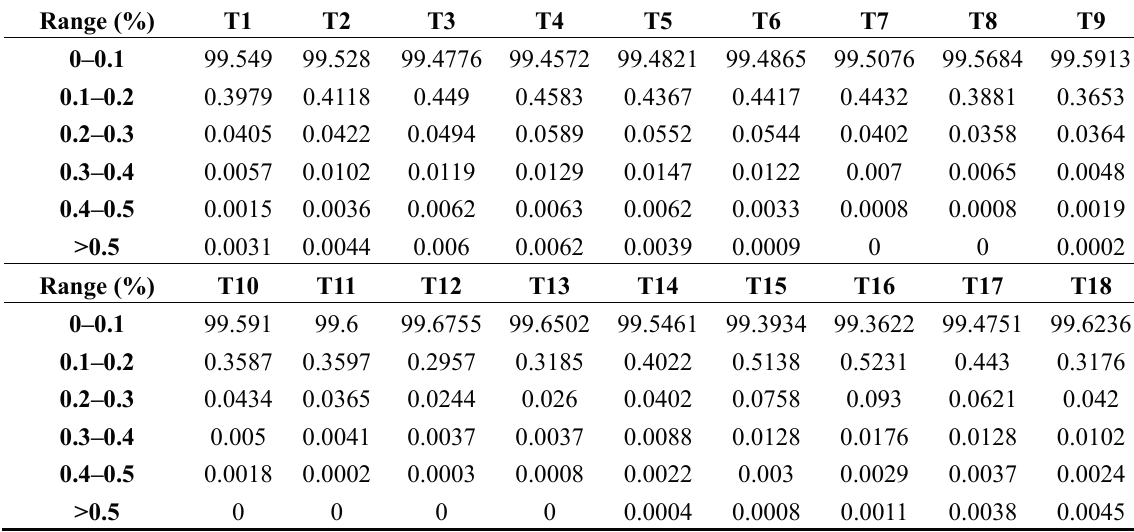
Table 3. Distribution range of residuals in 2000.